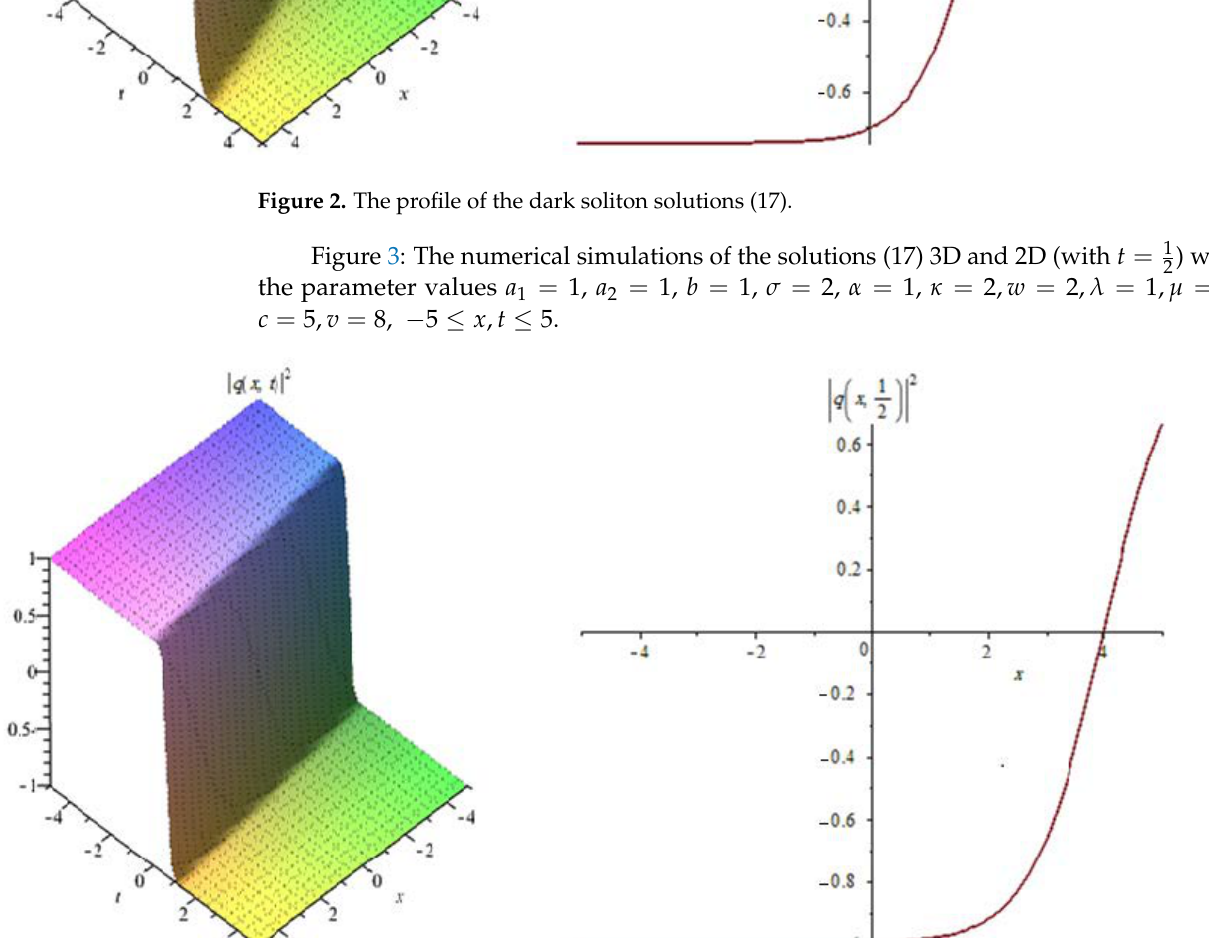
) with ) with ) with 2 2 2